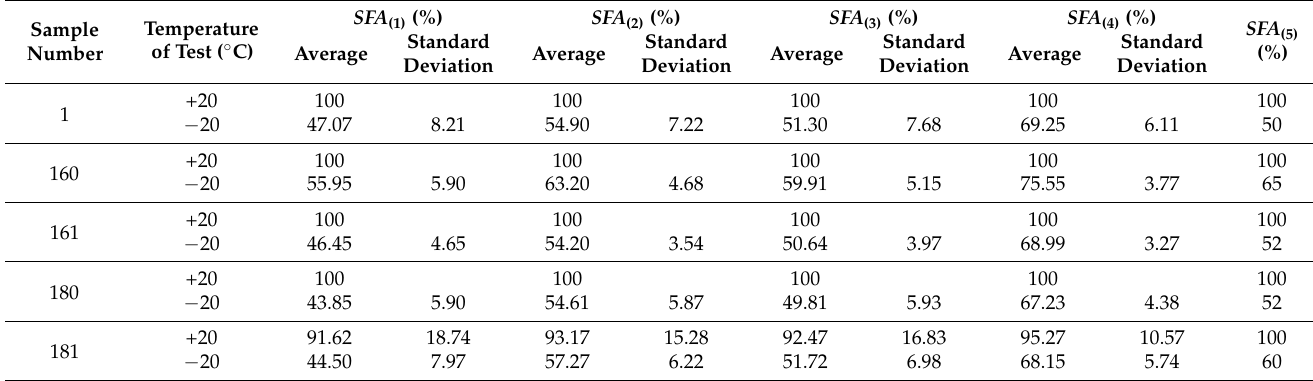
Table 3. Values of the SFA ( n ) (%) parameters for the S355J2+N steel, determined on impact toughness test fractures obtained during this research.